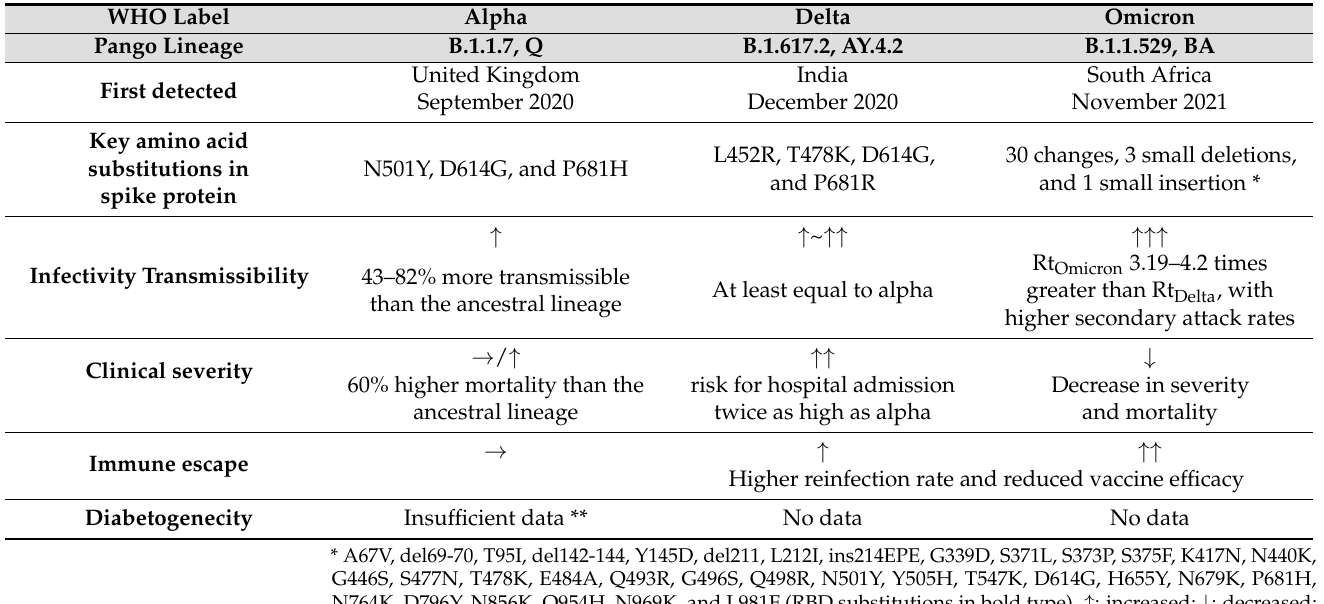
Table 1. Comparison of the characteristics of pandemic SARS-CoV-2